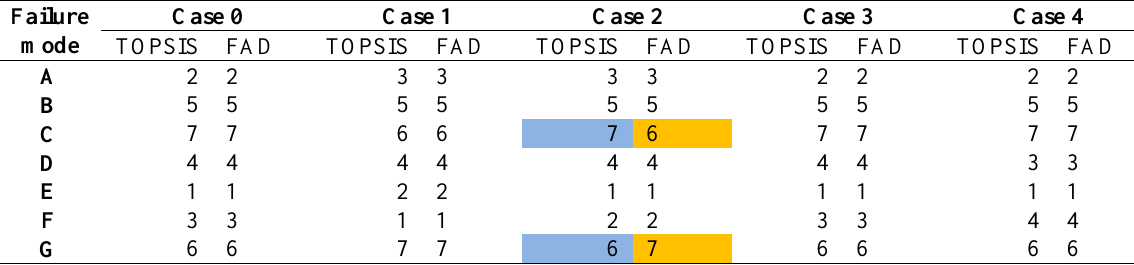
Table 11. Comparison of fuzzy TOPSIS and